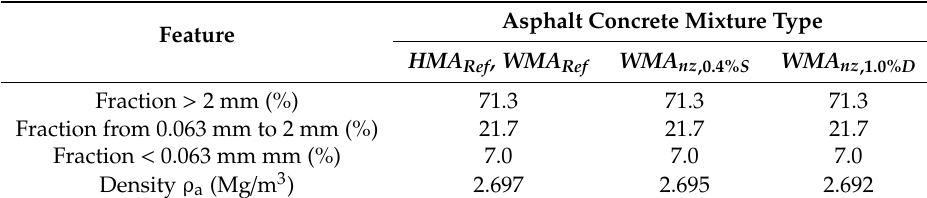
Table 6. The digest of sieving analysis of the designed asphalt concrete mixtures.